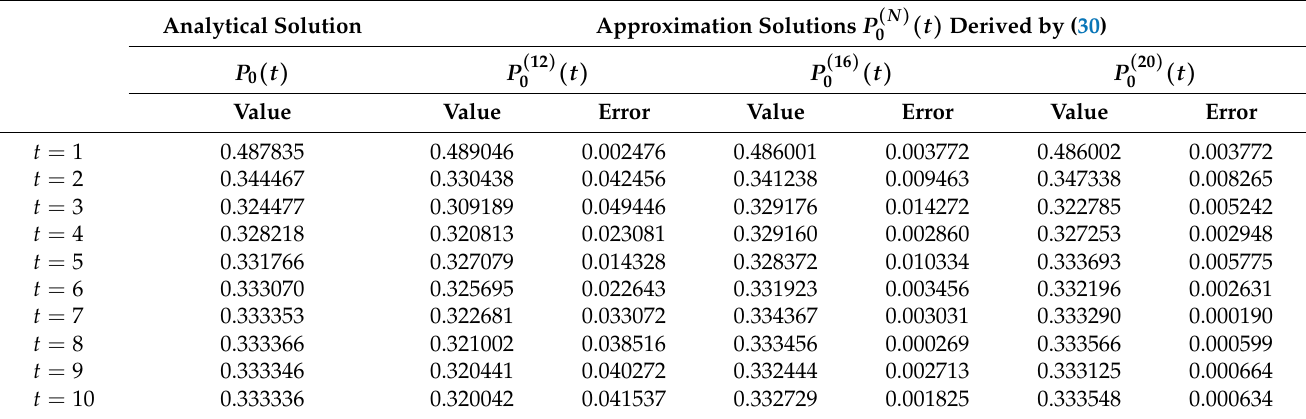
Figure 3. Approximation solutions P Table 1. The error analysis of solutions derived by the proposed scheme in different